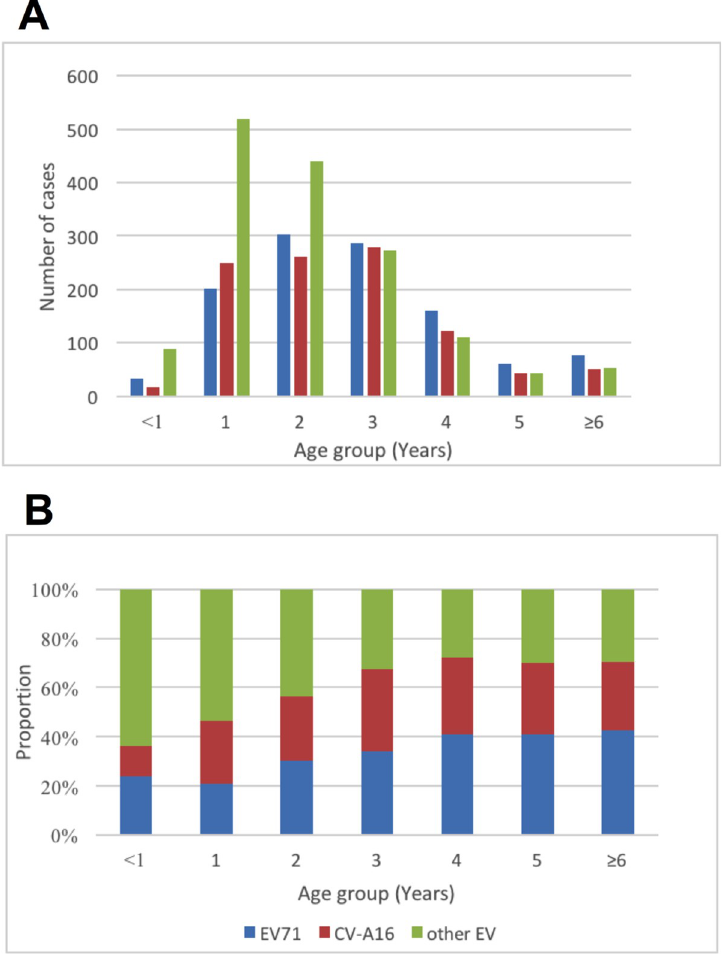
Fig 5. Enterovirus serotype distribution by age group in confirmed HFMD cases in Neijiang, Sichuan, China, 2012–2017.